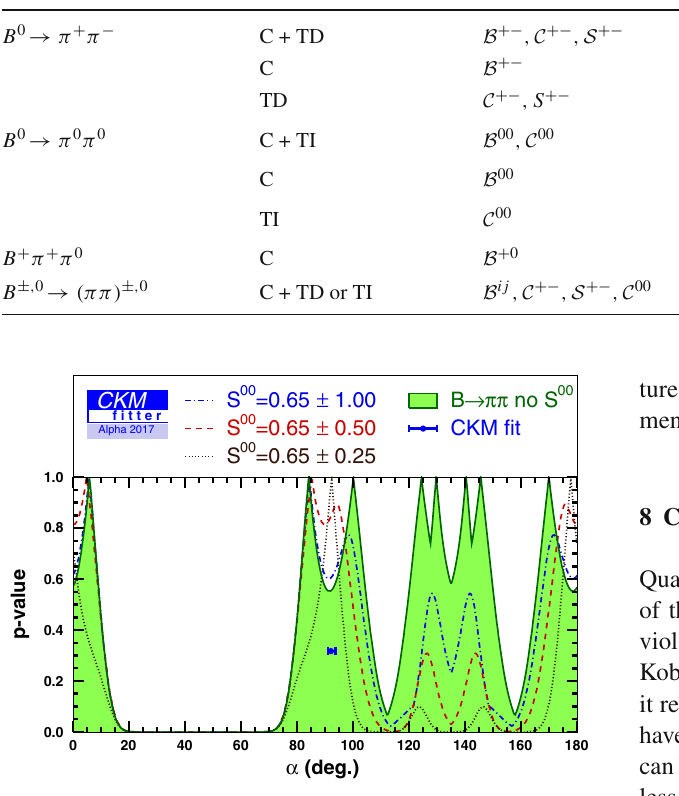
Table 13 68% CL interval for α from the SU ( 2 ) isospin analysis of the B → ππ data in the case that the uncertainty of some observables √ is reduced by a factor 2 (third column) or set to zero (fourth column). Decay